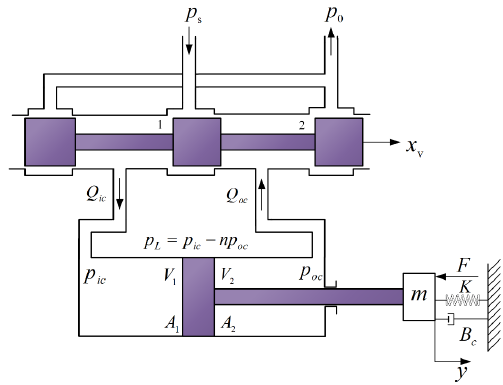
Figure 5. Valve-controlled asymmetrical cylinder system.